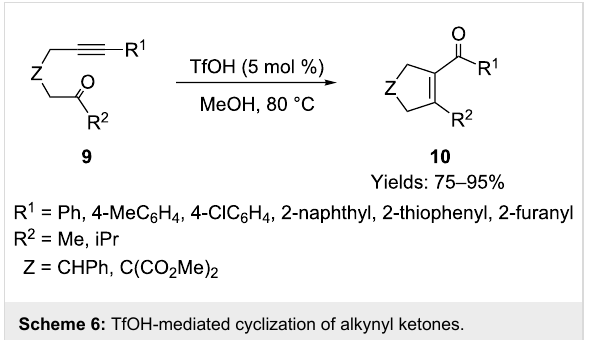
Scheme 6: TfOH-mediated cyclization of alkynyl